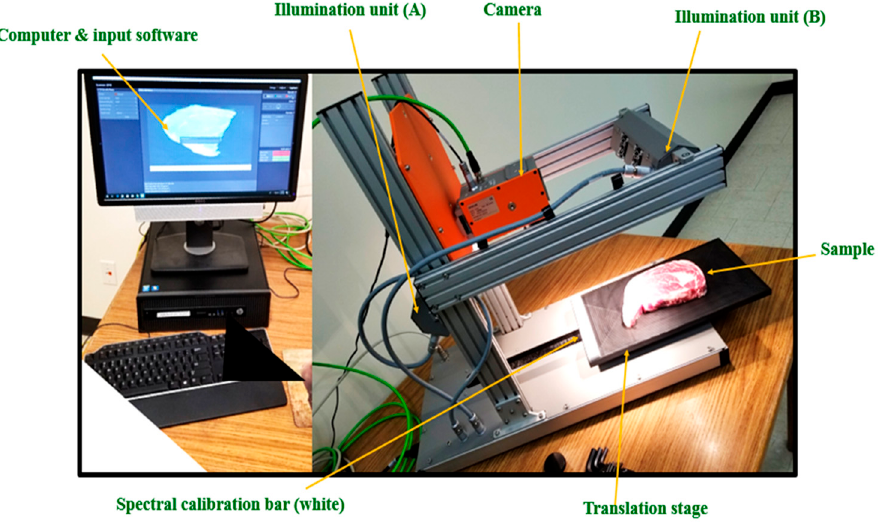
Figure 2. The designed hyperspectral imaging system.